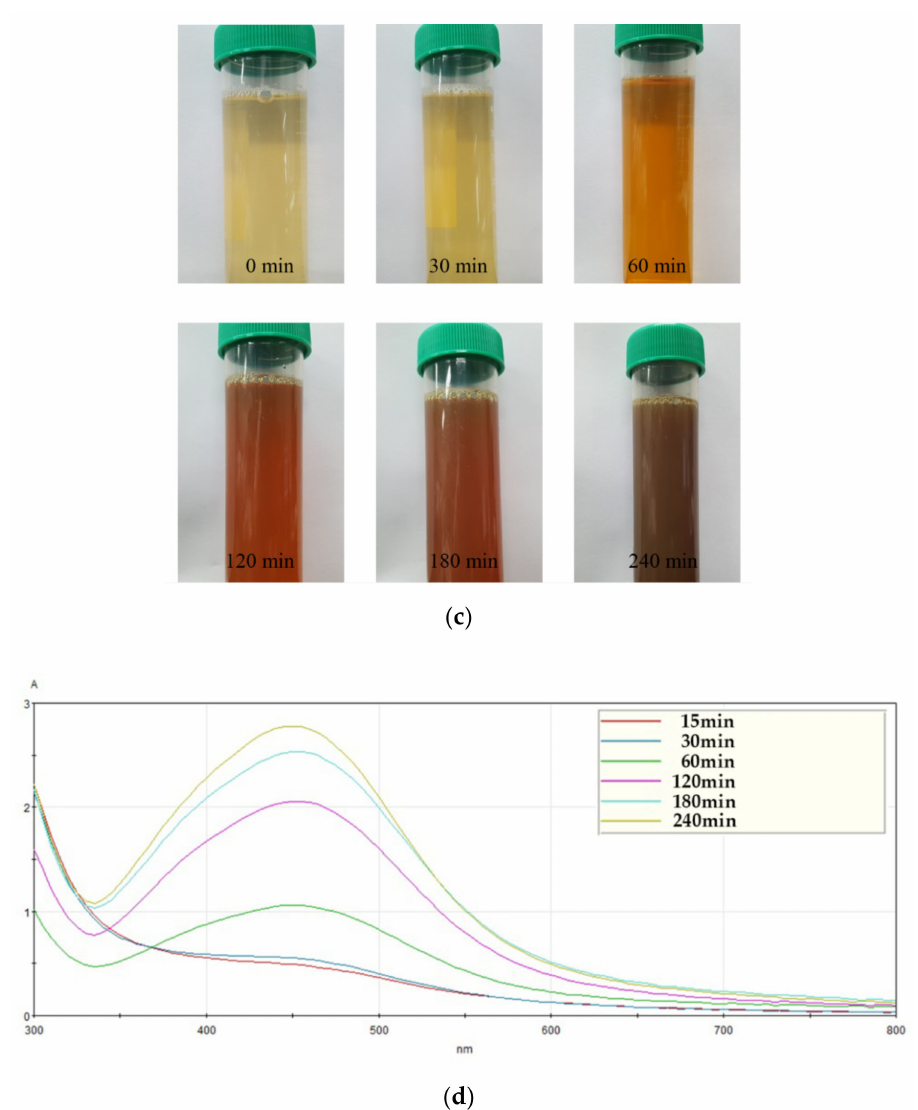
Figure 2. Absorbance spectra of AgNPs using A. catechu extract. ( a ) Absorbance spectra according to various AgNO 3 solution concentrations, ( b ) absorbance spectra according to various mixing ratios, and ( c ) color changes in the mixture according to reaction time and ( d ) time-dependent absorbance patterns of the mixture ( A. catechu extract:7 mM AgNO 3 solution,